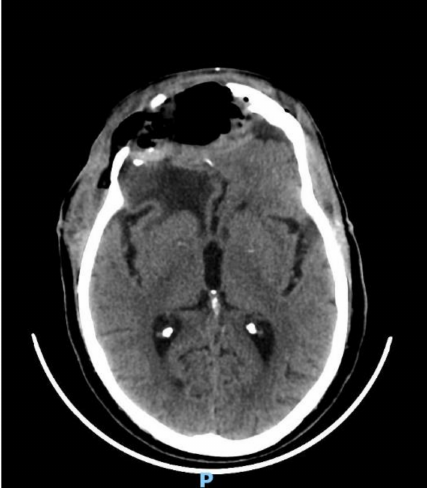
Figure 4. Brain MRI with evidence of a right frontal epidural empyema and meningioma recurrence (left, DWI; center, T1-weighted with contrast; right, T2-weighted).